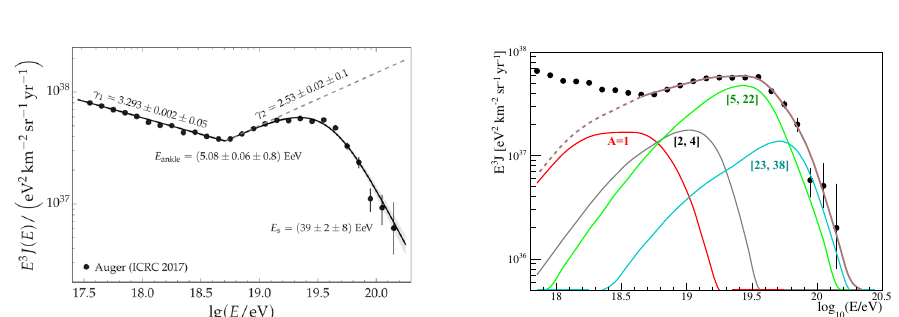
Figure 1. Spectrum measured by the Auger Observatory and fitted parameters obtained using a broken power- law with a high-energy supression (see text) [13]. The right panel shows the results obtained [14] by fitting the spectrum and X max observations with a model of sources with a mixed composition of H, He, N and Si having a power-law spectra with a rigidity dependent cuto ff . The individual curves depict the spectra at the Earth for di ff erent mass groups after the propagation and interactions with background radiation fields are taken into account. They correspond to the mass groups A = 1 (red), 2 ≤ A ≤ 4 (grey), 5 ≤ A ≤ 22 (green) and 23 ≤ A ≤ 38